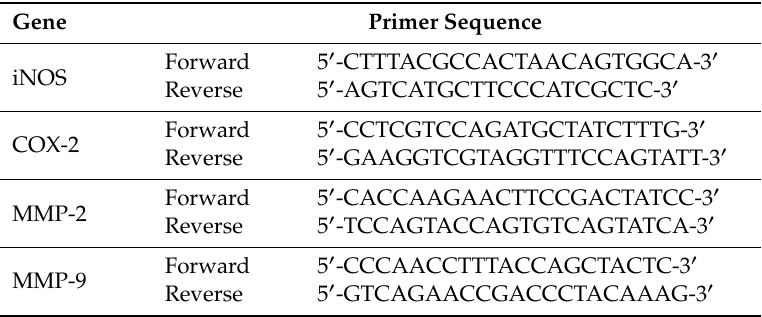
Table 2. List and sequences of real-time PCR primers for mRNA